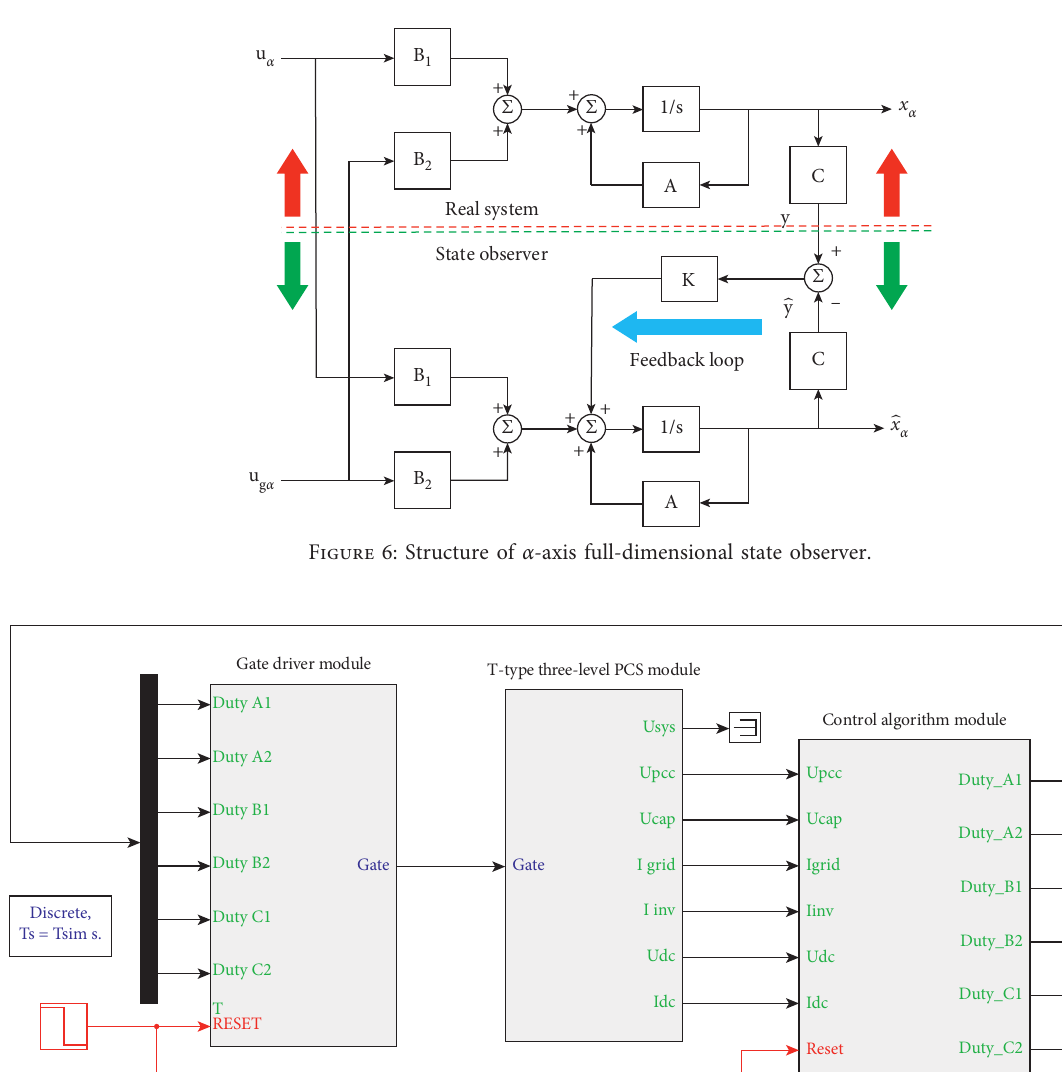
Control algorithm